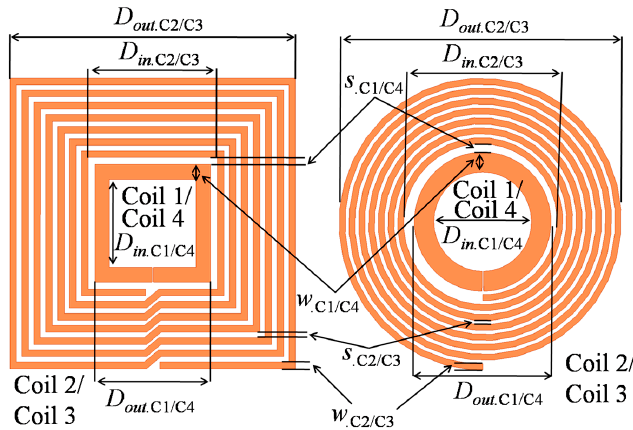
Figure 2. Geometrical architecture of the square- and circular-shaped resonators.